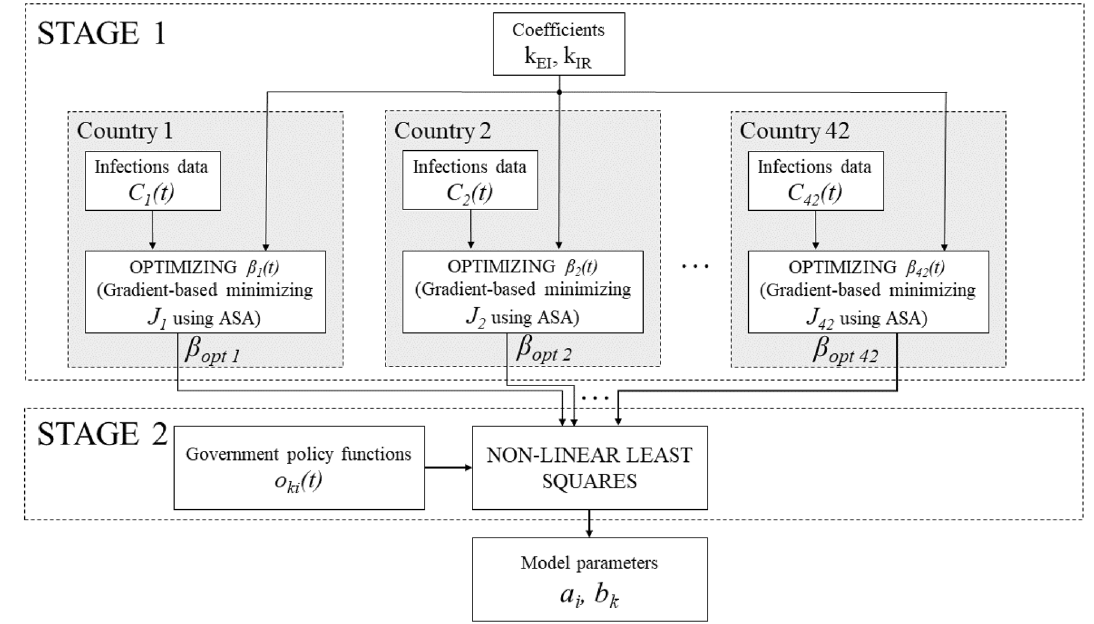
Figure 4. Two-stage parameter estimation workflow for a single set of k EI and k IR values. For each country, optimal β( t ) is estimated based on cumulative cases using adjoint sensitivity analysis. Based on all the β opt ( t ) functions and restriction functions o ki ( t ) , model parameters are estimated with non-linear least